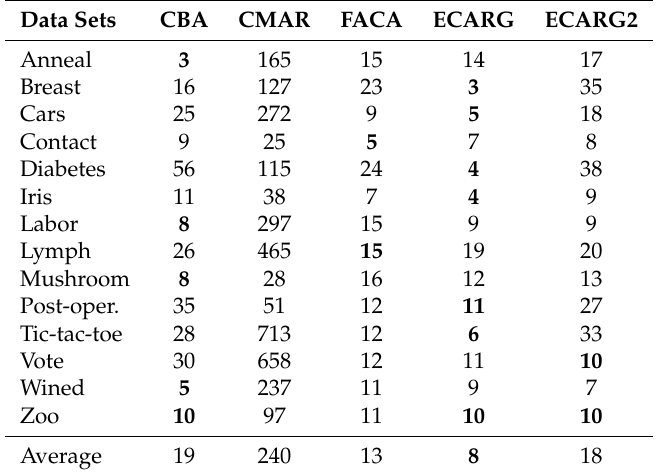
Table 11. The average number of generated rules on the UCI